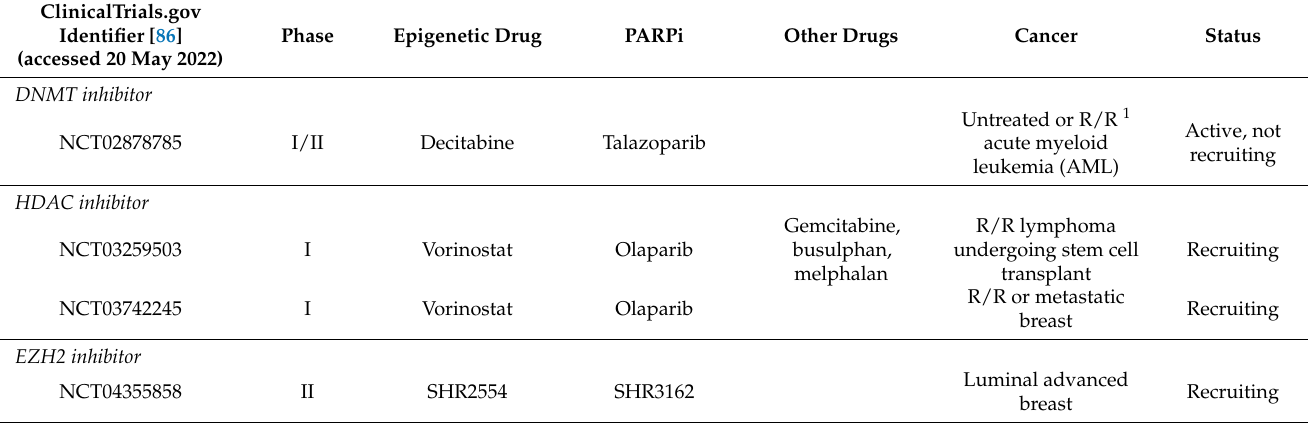
Table 1. Clinical trials evaluating epigenetic therapy in combination with